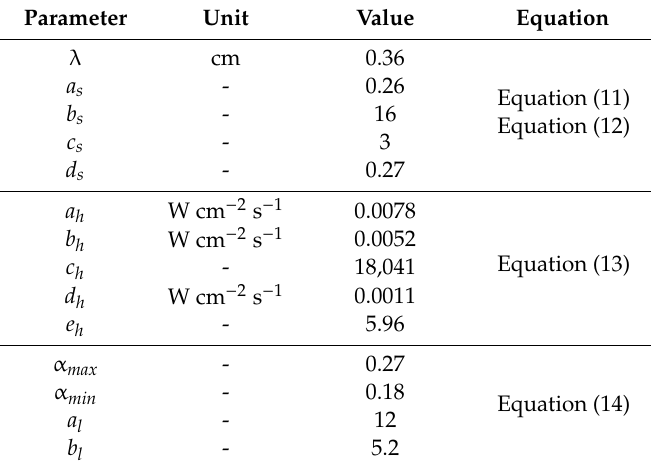
Figure 3. Soil water retention and hydraulic conductivity curves of the soil taken in Dongola, Sudan. Table 1. Parameter values for solute and heat movement for the soil.